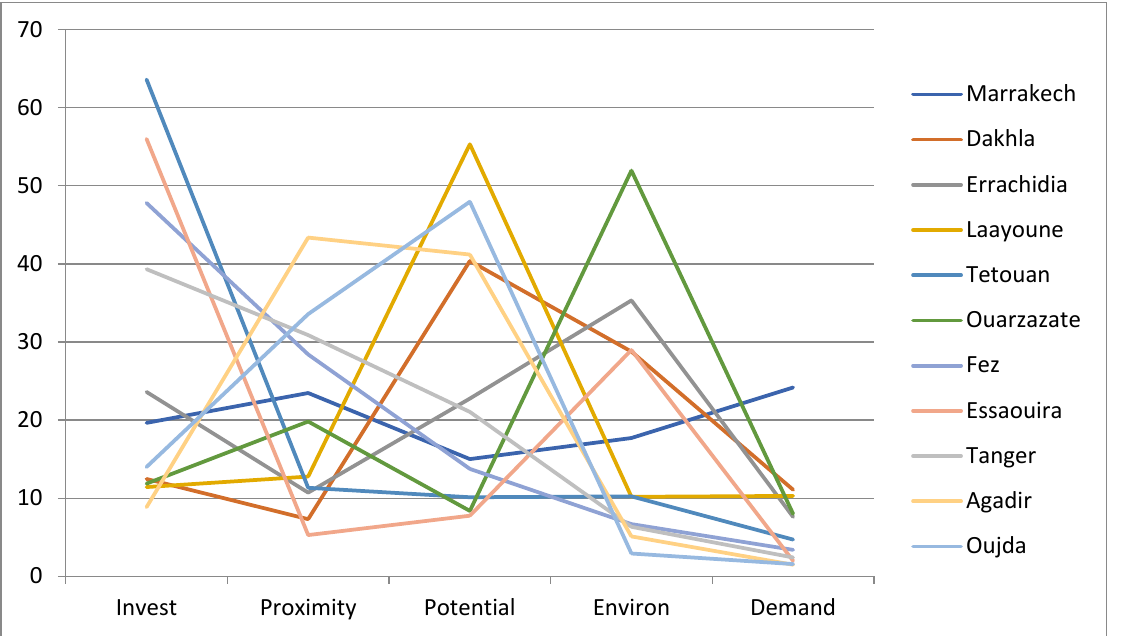
Figure 7. Second analysis with electricity consumption as the new criterion. Central weights for the alternatives.